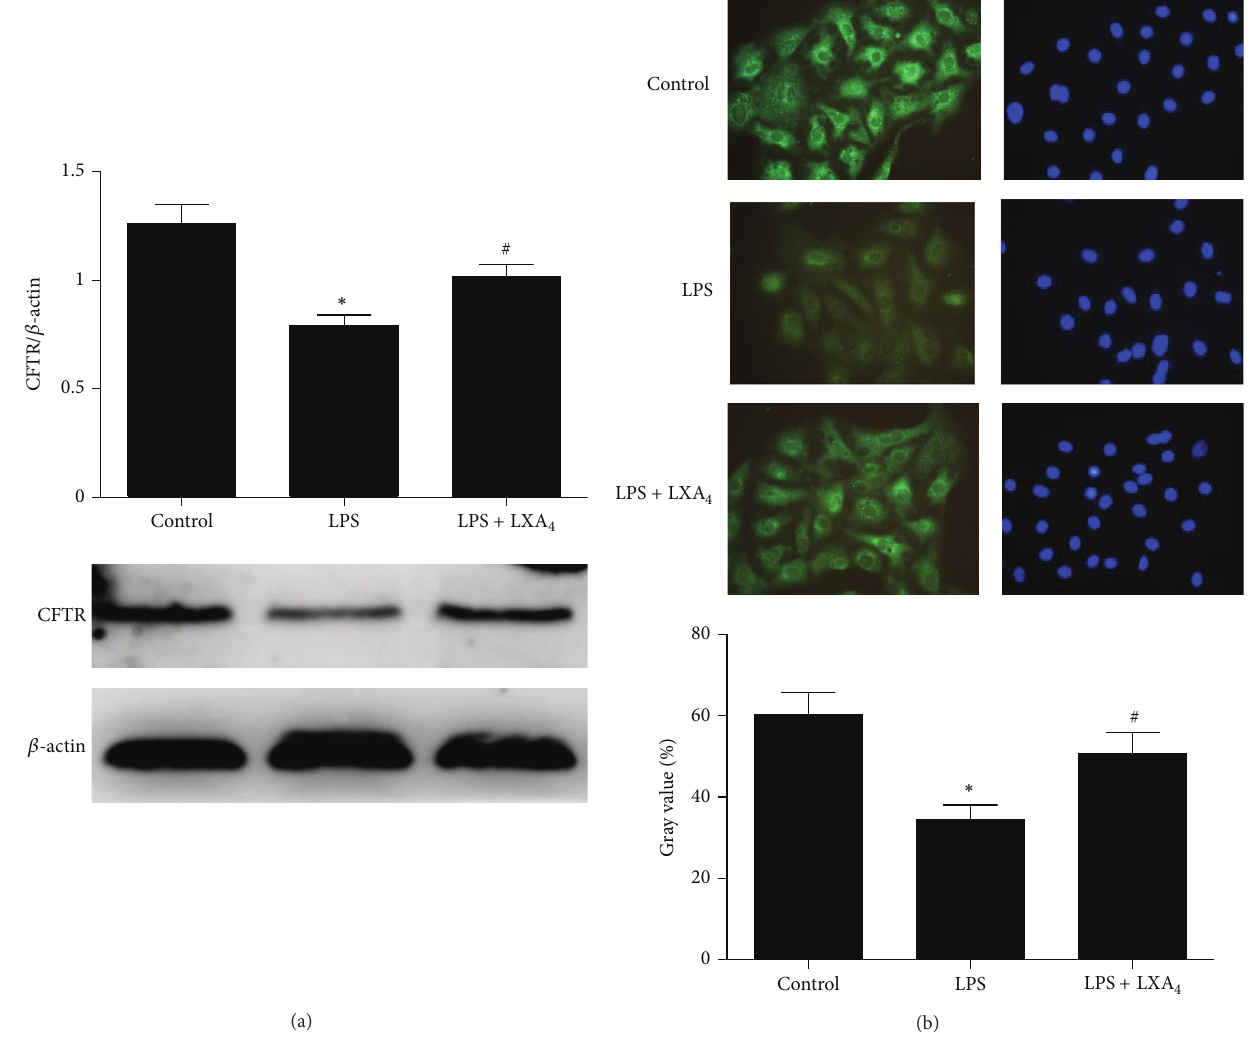
Figure 4: Effects of lipoxin A 4 on protein expression of CFTR in primary ATII cells. The cells were treated with lipoxin A 4 (100nM) in the presence of LPS (1 𝜇 g/mL) for 6 hours. (a) After incubation, the cells were harvested, sonicated and CFTR protein detected by western blotting. (b) The protein expression of CFTR also was detected by immunofluorescence assay. Data were expressed as mean ± SEM for each group. ∗ 𝑃 < 0.05 versus control group, # 𝑃 < 0.05 versus LPS group, 𝑛 = 4 for each group. LPS = lipopolysaccharide, LXA 4 = lipoxin A 4 , CFTR = cystic fibrosis transmembrane conductance